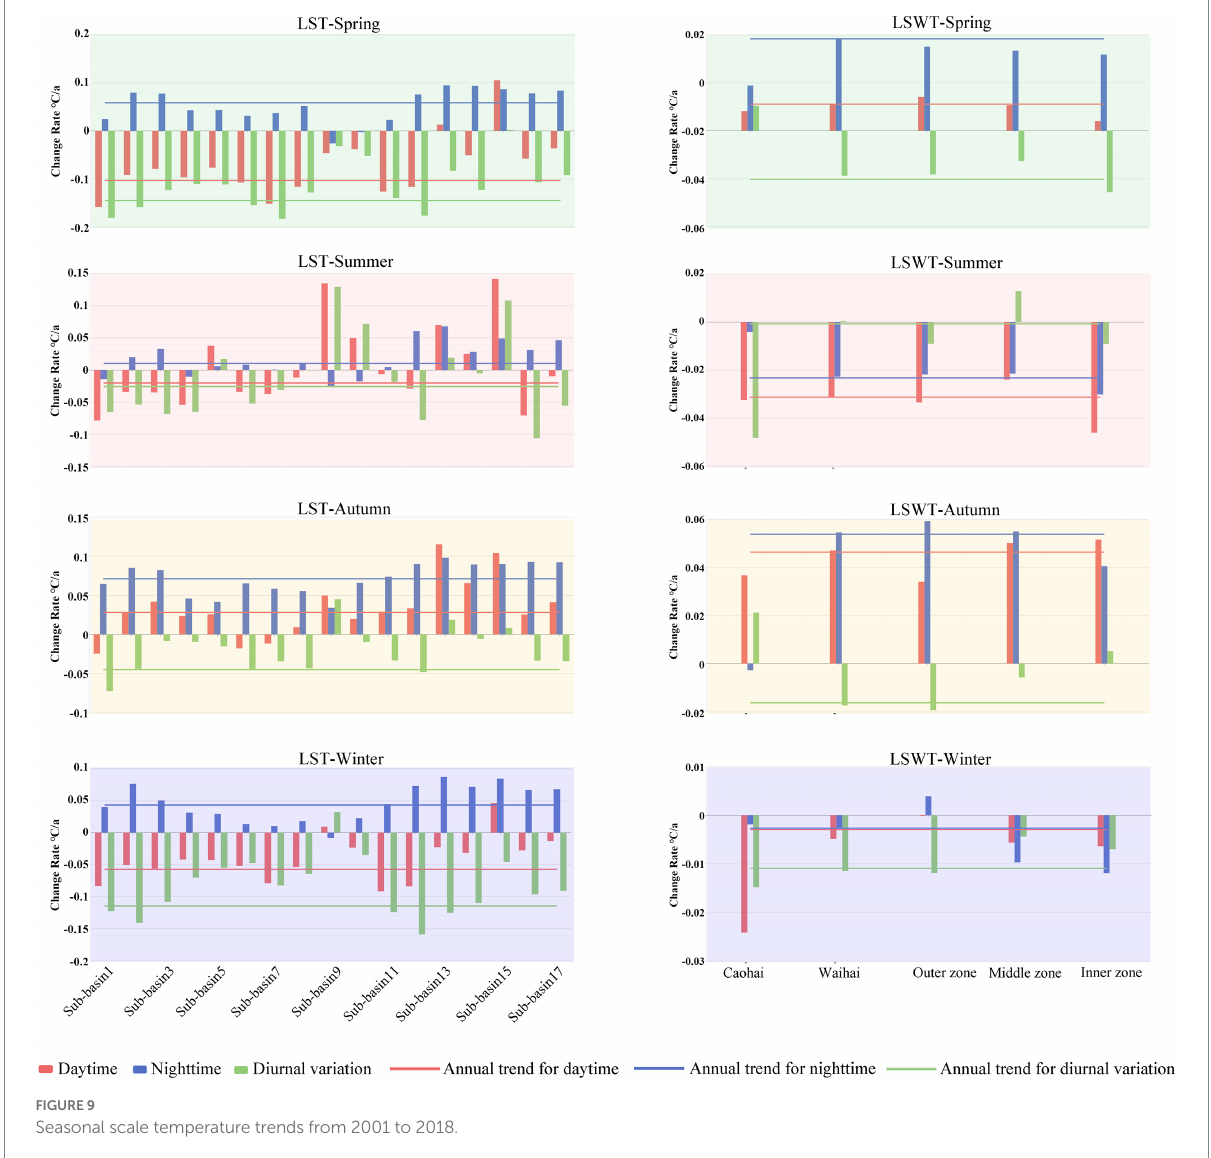
FIGURE 9 Seasonal scale temperature trends from 2001 to